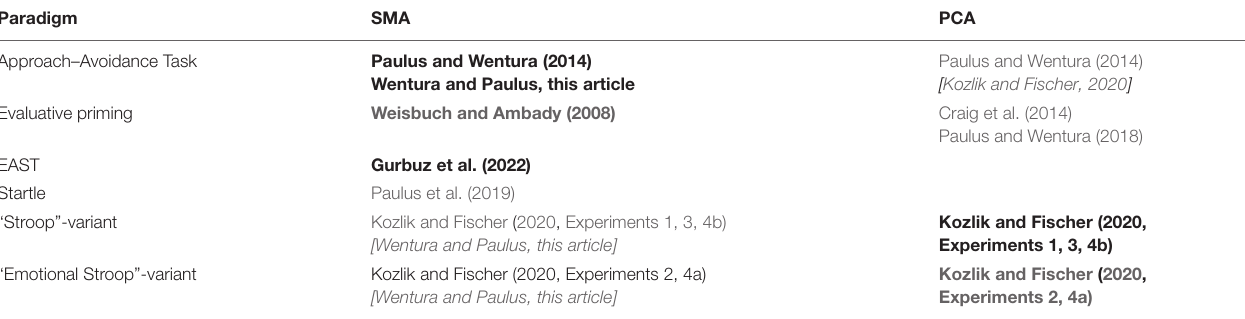
TABLE 2 | Evidence for the social message account (SMA) and the processing conflict account (PCA). Paradigm SMA Approach–Avoidance